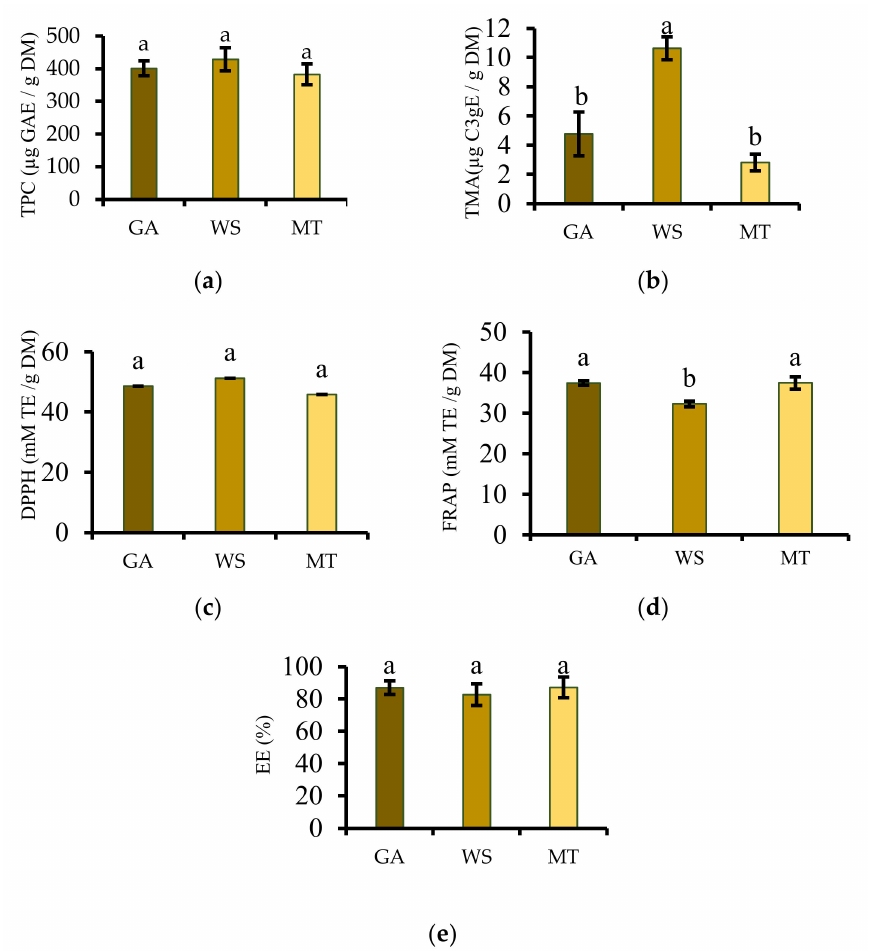
Figure 4. ( a ) Total phenolic content (TPC), ( b ) total monomeric anthocyanin (TMA), ( c ) DPPH radical scavenging activity, ( d ) ferric reducing antioxidant power (FRAP), and ( e ) encapsulation efficiency of the freeze-dried passion fruit peel powders. According to Duncan’s multiple-range test, different letters on each bar indicate significant differences in the means ( p < 0.05). The standard deviation of the mean is represented by vertical bars in each column graph. MT = maltodextrin, WS = waxy starch, GA = gum arabic, and EE = encapsulation